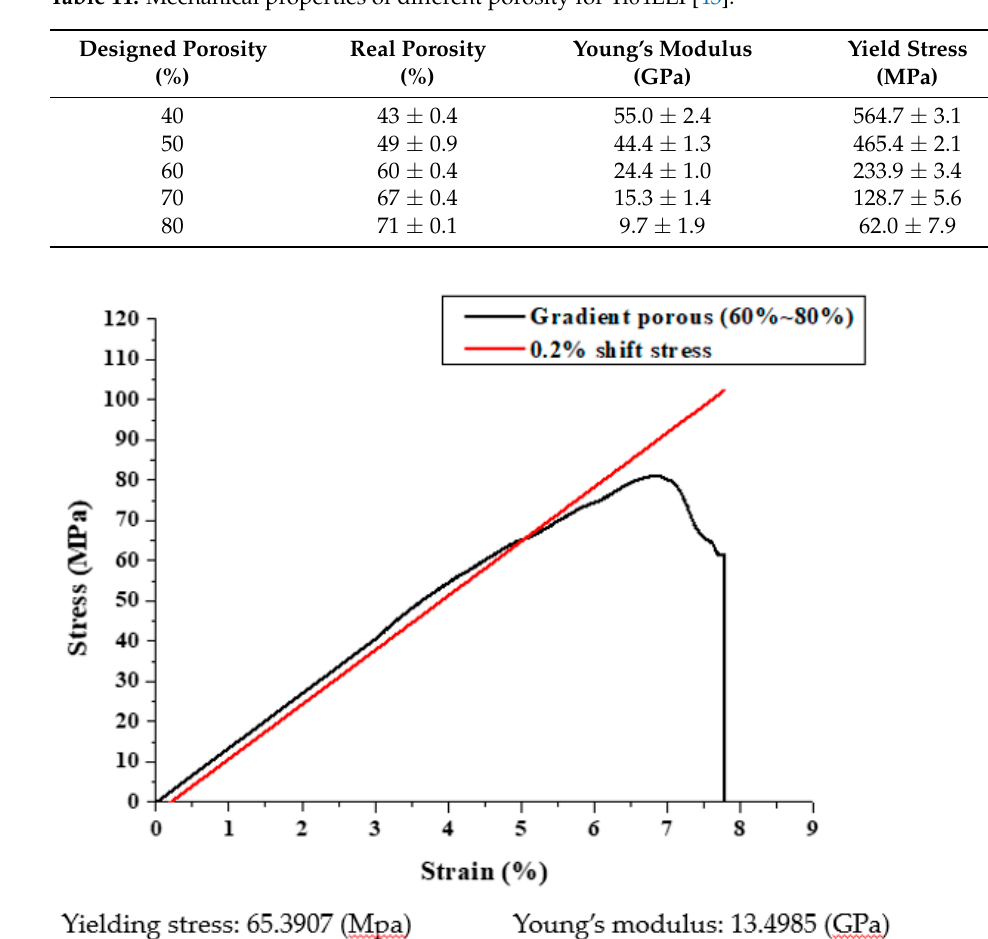
Table 11. Mechanical properties of different porosity for Ti64ELI [43].